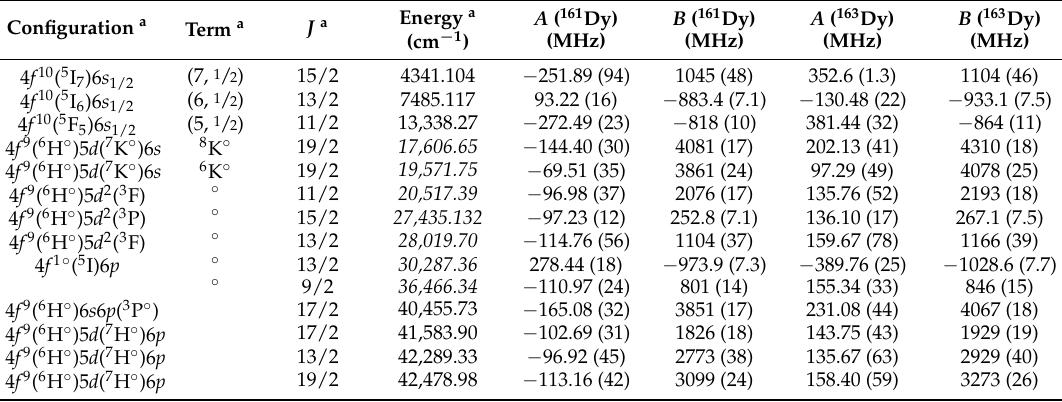
Table 2. Hyperfine structure constants of levels of 161 Dy II and 163 Dy II derived from transitions where satellite peaks are well fit. A and B are the magnetic dipole and electric quadrupole constants, respectively. J is the total angular momentum. Energies of odd-parity levels are